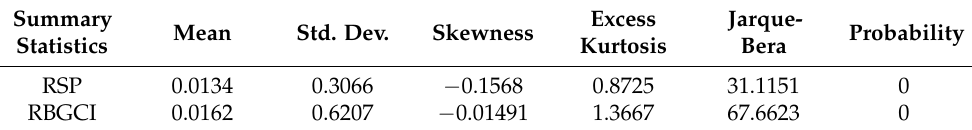
Table 1. Summary Table 1. Summary Statistics.